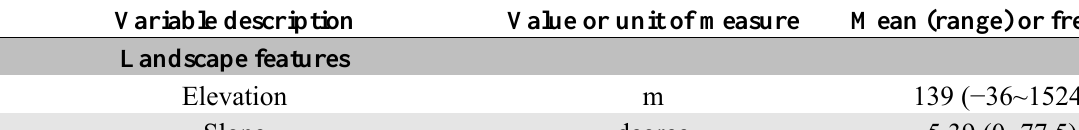
Table 1. Descriptions, values or units of measure, and means or frequencies of landscape features, forest conditions, and management activities and disturbances evaluated as potential determinants of site invasion by L. japonica on forested plots in the southern United